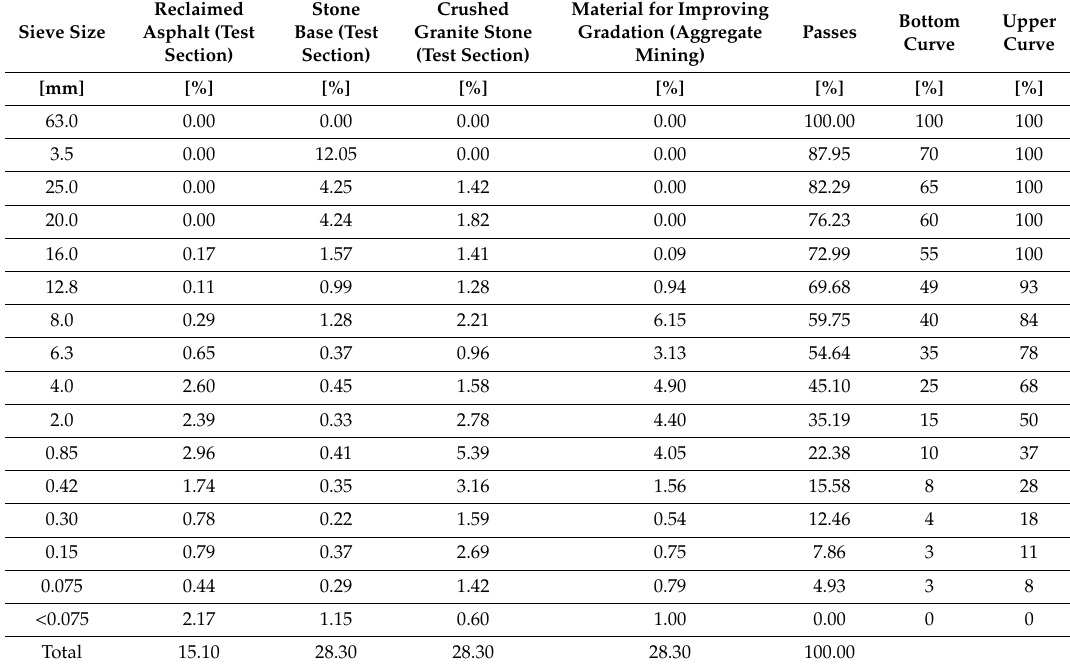
Table 1. Grading of the mineral